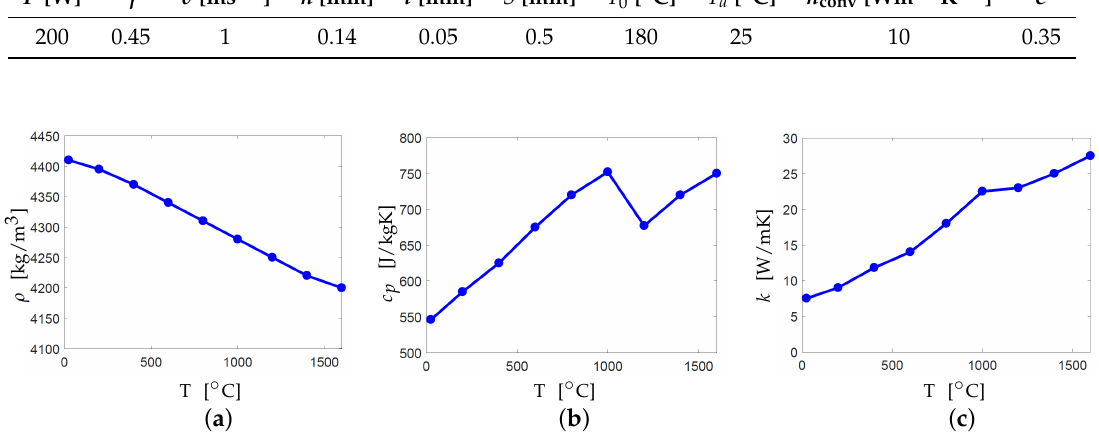
Figure 2. Variation of temperature-dependent bulk properties of Ti-6Al-4V. ( a ) Density ( b ) Specific heat and ( c ) Thermal conductivity [24].